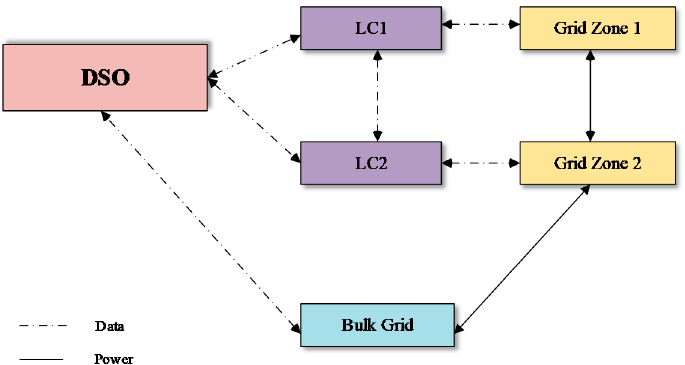
Figure 3. Overview of the relationship between energy exchange and data between local market components.